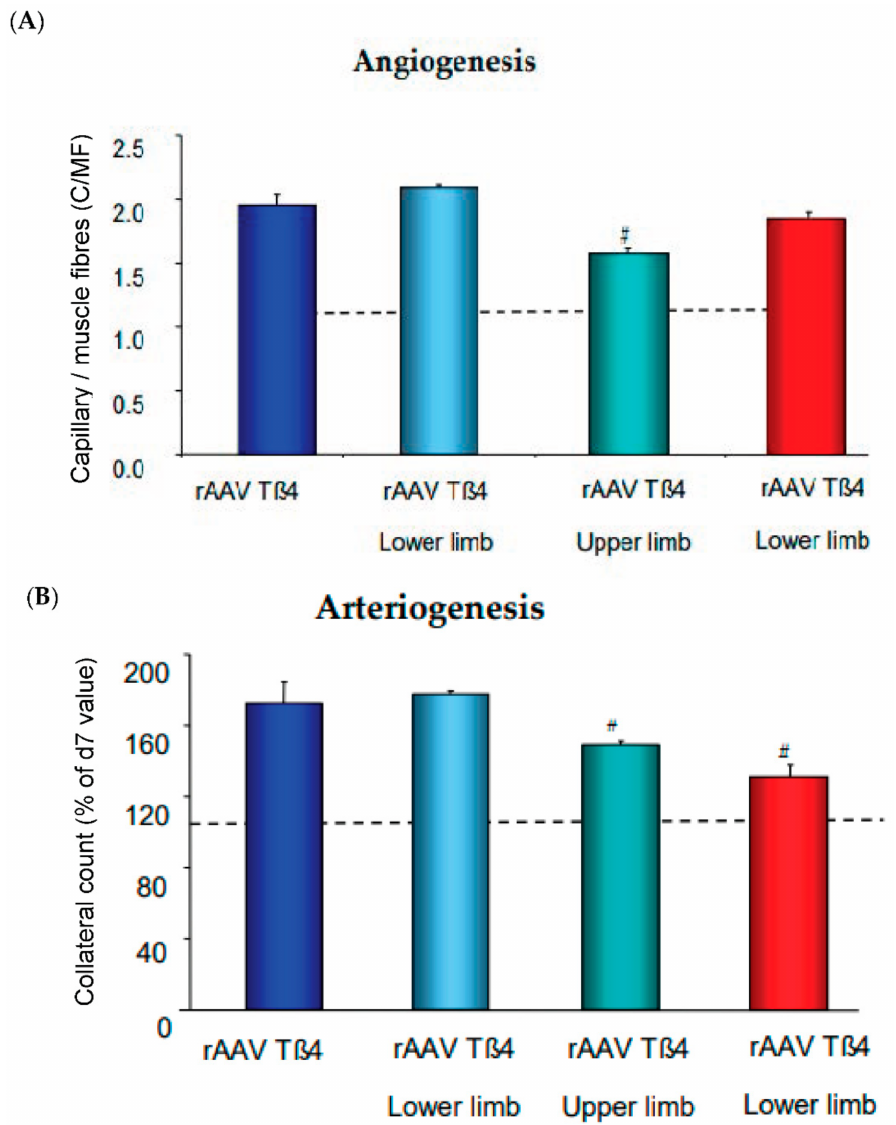
Figure 3. Angiogenesis and arteriogenesis upon recombinant AAV (rAAV) encoding for Thymosin ß4 (Tß4). ( A ) Capillary/muscle fiber ratio (C/MF) after application of rAAVTß4 either whole limb (retrograde venous infusion) or lower limb (intramuscular injection) with or without L-NAME coapplication. ( B ) Collateral count (% of d7 level) at d28. Dotted lines are control group levels. For methods cf.